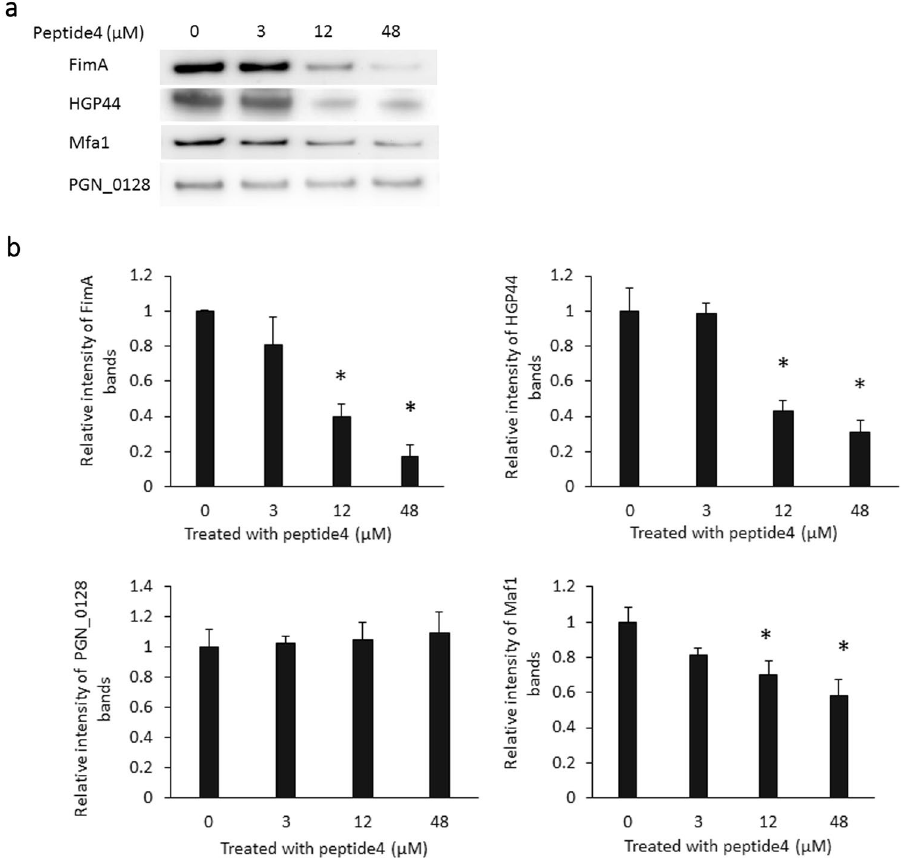
Figure 7. Production of fimbrial proteins and gingipains in P . gingivalis in response to peptide4. ( a ) Expression levels of FimA, Mfa1, Hgp44 of gingipains, and PGN_0128 (immunoreactive 53 kDa antigen) in surface extracts of P . gingivalis 33277 exposed to pwptide4 at concentrations 0, 3, 12, and 48 µ M were analyzed using a Western blot analysis. ( b ) Semiquantitation of western blots was conducted with ImageJ software. Each bar represents the intensity of the protein band. An asterisk indicates a significant difference between the relative intensity of the protein bands in P . gingivalis exposed to peptide4 (3, 12, or 48 µ M) compared to those seen in P . gingivalis not exposed (0 µ M, 1 unit) ( P < 0.05 by t test).